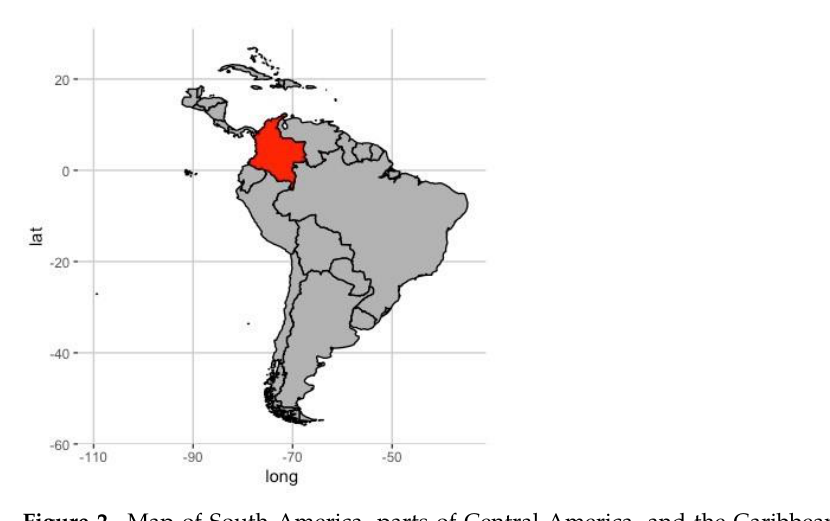
Figure 1. Map of the study area used in the Spanish language digital survey comprising northern Bogotá Distrito Capital (D.C.) and the surrounding peri-urban areas.